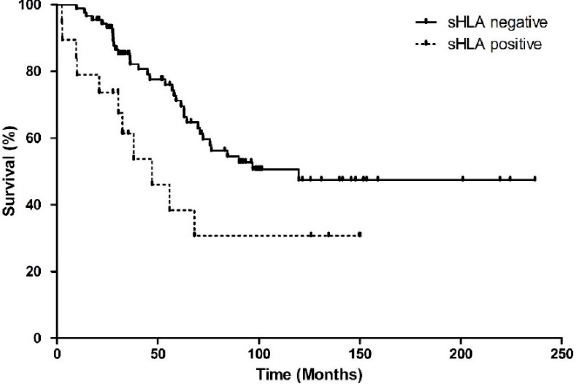
Figure 1. Kaplan–Meier survival curve showing melanoma-related survival, since enucleation, based on the sHLA expression in the aqueous humour of 108 UM patients. Curves represent the negative and positive sHLA groups. Both groups differ significantly in survival (Log Rank test p = 0.025).